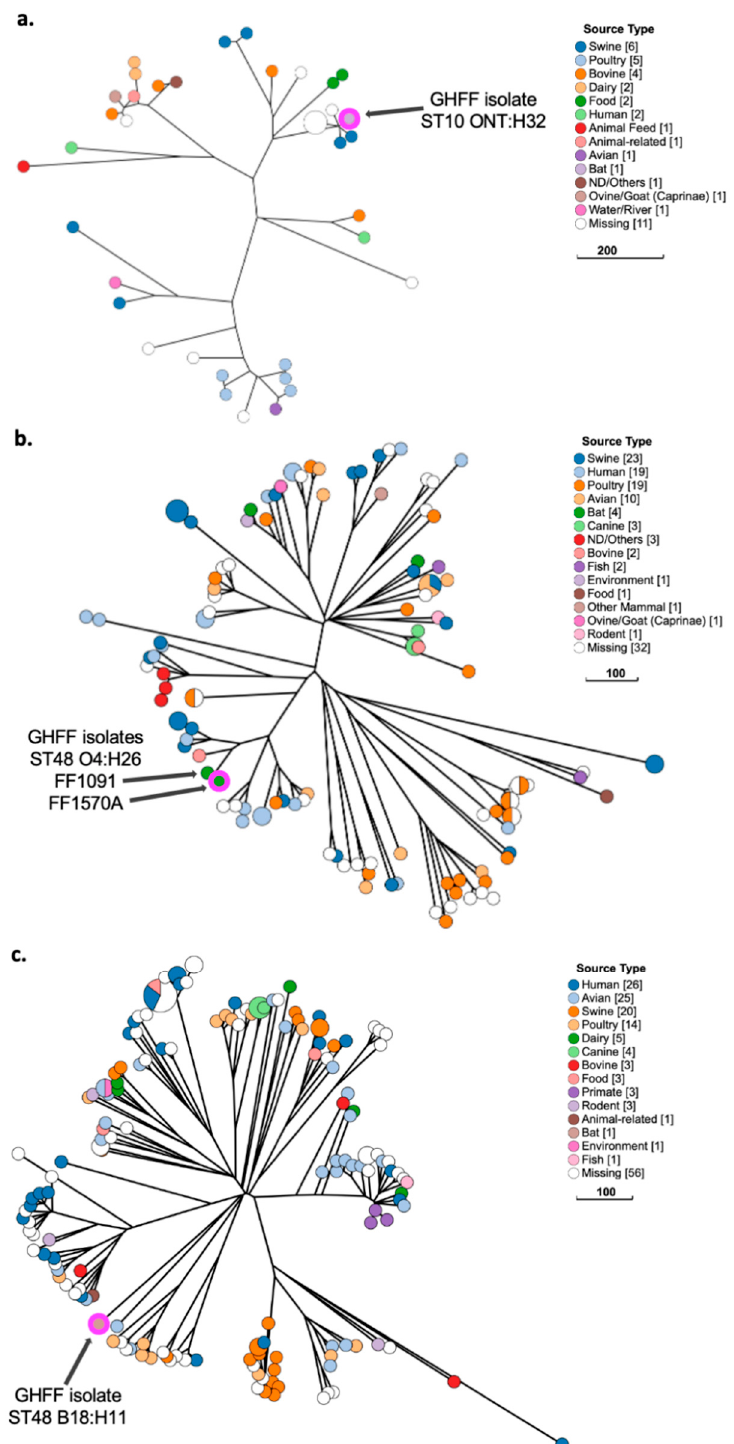
Figure 6. Phylogenetic and metadata analysis of three low-pathogenicity ST10 complex E. coli isolates from grey-headed flying fox (GHFF) pups and closely related isolates from human, animal, and environmental sources identified in EnteroBase. GrapeTree phylogeny constructed using a rapid neighbour joining (RapidNJ) minimum spanning tree based on the cgMLST V1 + hierarchical clustering (HierCC) V1 scheme. Scale bars indicate the number of cgMLST allelic differences. GitHub URL links for interactive versions of all GrapeTrees are provided in Supplementary Table S4. ( a ) ST10 ONT:H32; ( b ) ST48 O4:H26; ( c ) ST48